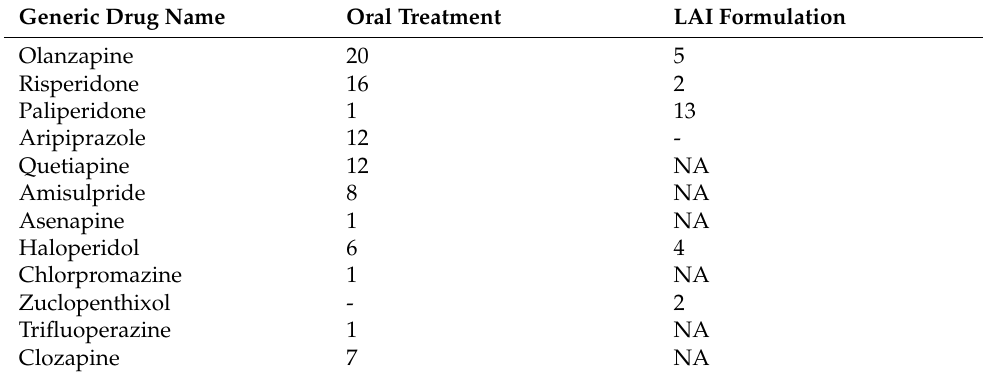
Table 2. Patients’ antipsychotic regimen.